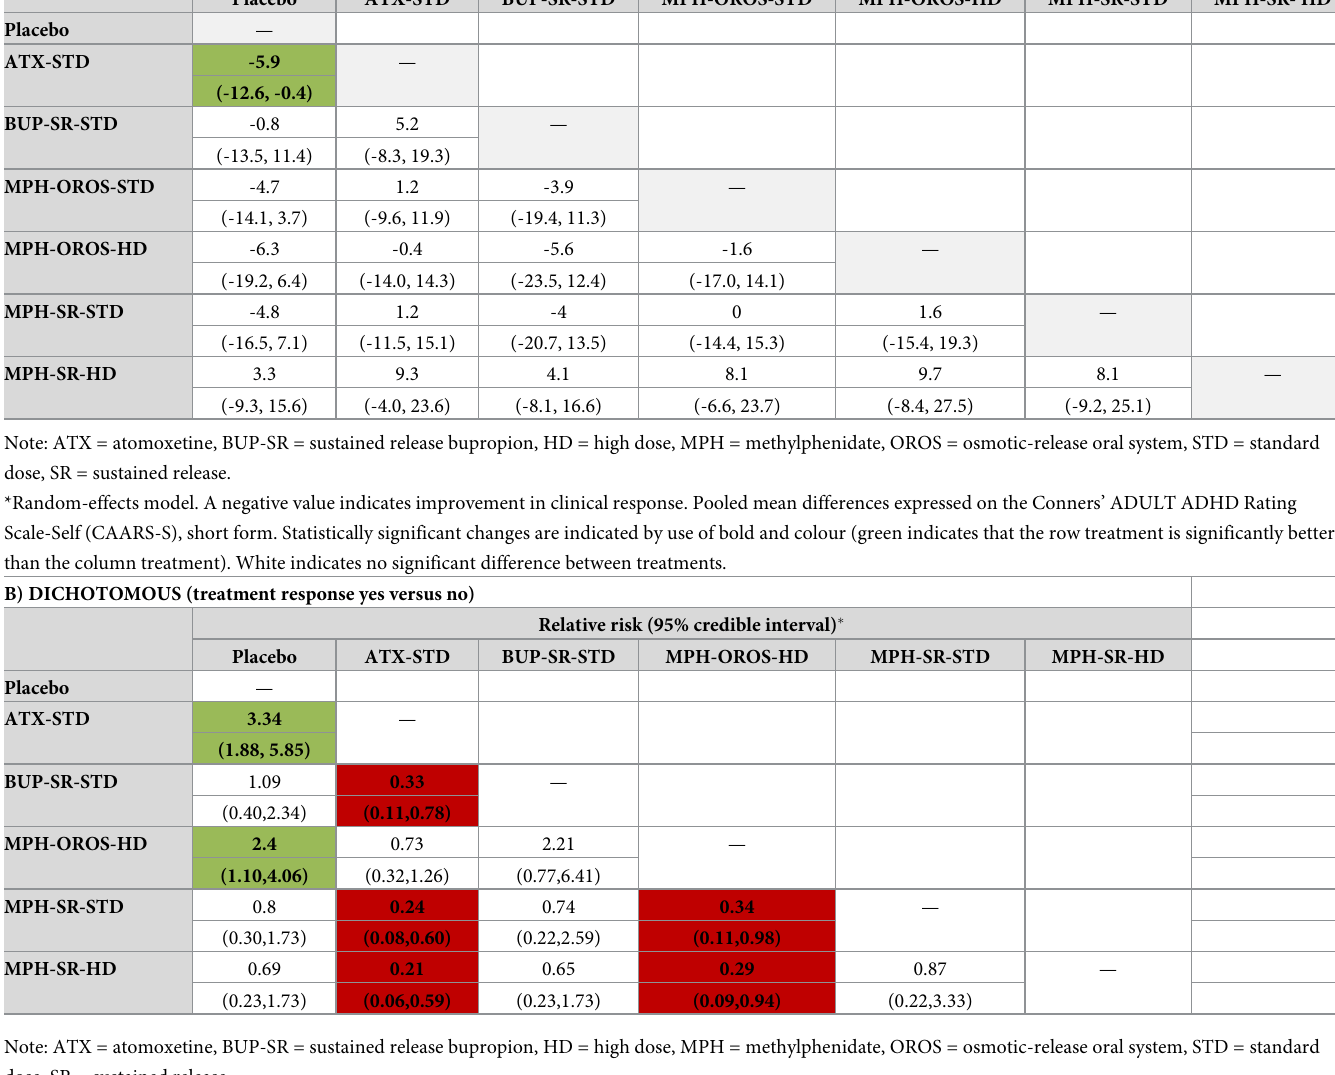
Table 4. Patient-reported clinical response in trials with a treatment duration of at least 12 weeks–indirect comparison of ADHD pharmacotherapies. A) CONTINUOUS measure of